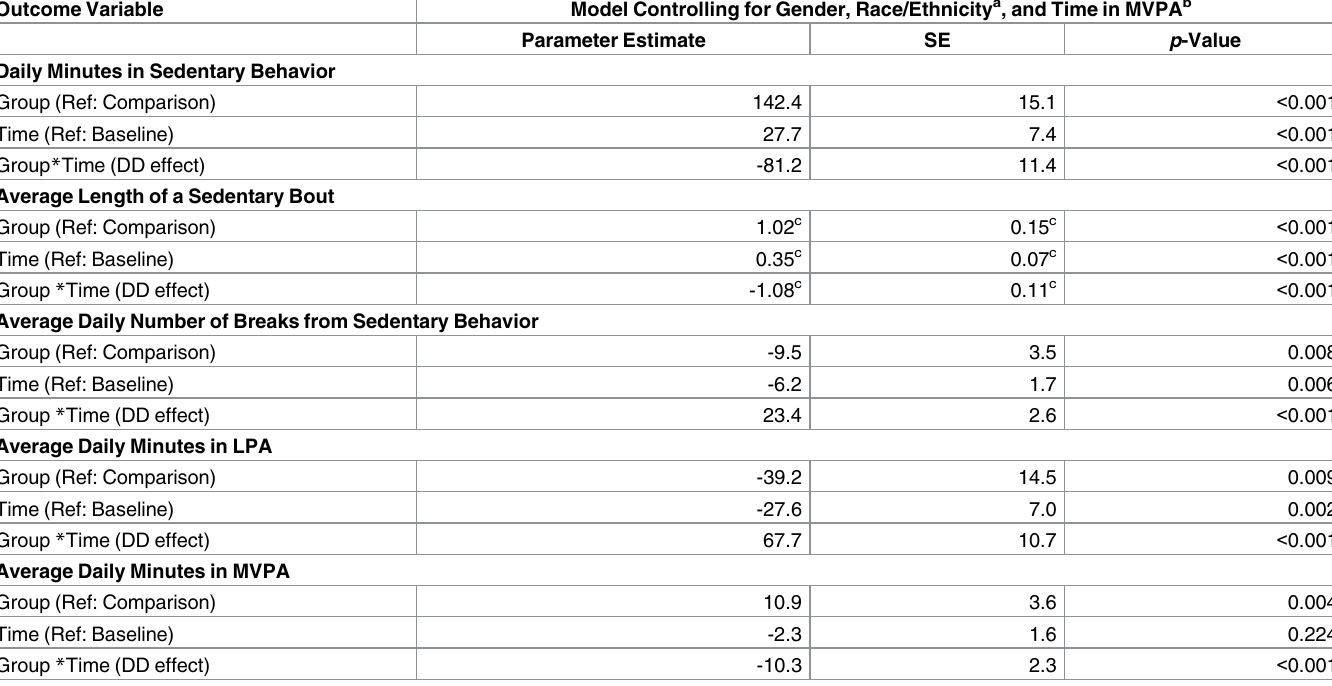
Table 2. Difference-in-difference (DD) estimatesof the impact of school architecture intervention effectson sedentarybehavior and physical activity. Outcome Variable